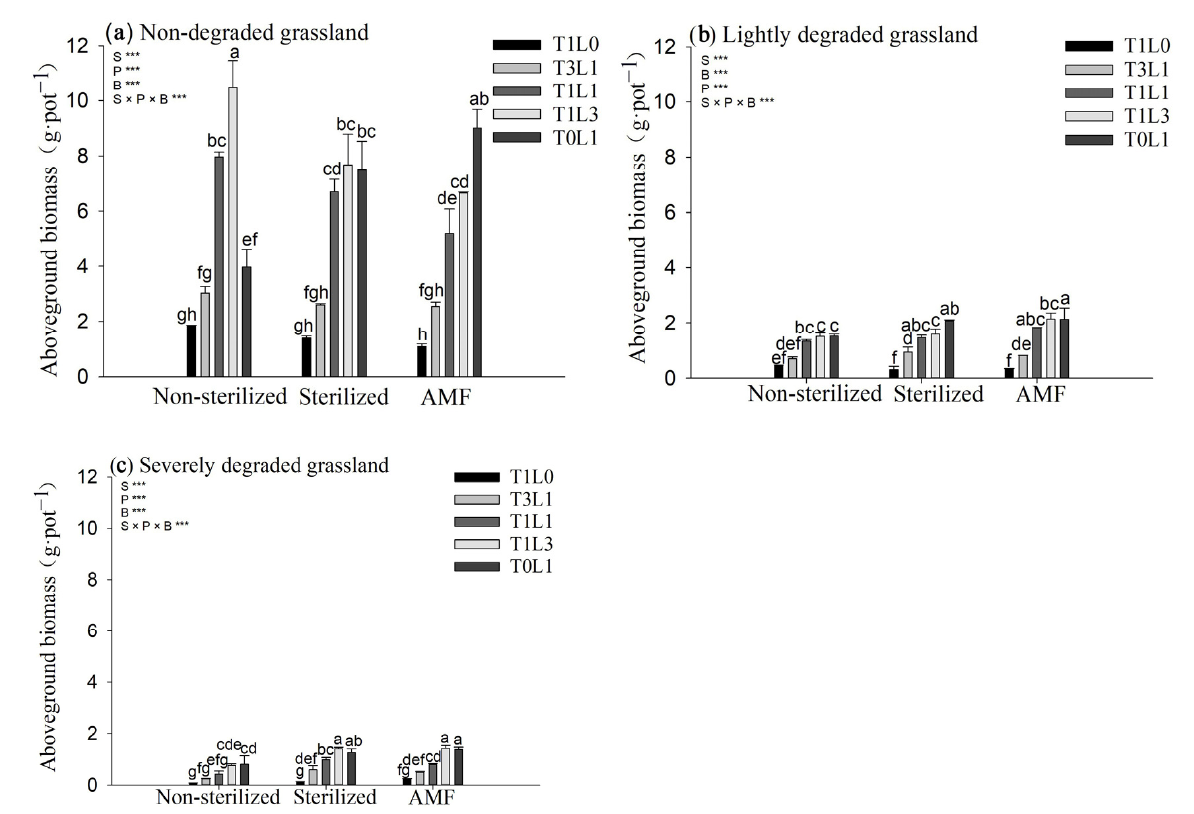
Figure 2. Effects of different treatments on plant community productivity. ( a ) Effects of soil type (S), planting ratio (P) , biological treatment (B) and their interactions (S × P × B) on aboveground biomass in non-degraded grassland soil ( b ) Effects of soil type (S), planting ratio (P) , biological treatment (B) and their interactions (S × P × B) on aboveground biomass in lightly degraded grassland soil. ( c ) Effects of soil type (S), planting ratio (P) , biological treatment (B) and their interactions (S × P × B) on aboveground biomass in severely degraded grassland soil. Different letters indicate the significant differences among treatments ( p < 0.05). *** p < 0.001 indicate the significance level of each treatment. Note: soil degradation degree (S); planting ratio (P); soil biological treatment (B). T1L0, T3L1, T1L1, T1L3, T0L1 mean planting ratio of T. repens and L. perenne : 1:0, 3:1, 1:1, 1:3, 0:1, respectively. Arbuscular mycorrhizal fungi inoculation improved the plant nutrient contents (Figures 3b and 4b,c). In LDG and SDG soils, AMF inoculation increased the plant shoot N and P contents. However, AMF inoculation did not improve the plant shoot N and P contents in NDG soil (Figure 3b). The plant shoot N content was the highest under T1L0 in NDG soil. AMF inoculation increased the plant shoot P content in plant communities with a high proportion of T. repens in LDG and SDG soils (Figure 4). The plant N/P ratio in NDG soil was significantly lower than that in LDG and SDG soils (Figure 5). Overall, for NDG soil, the average plant N:P ratio was 3.66 ± 0.34 (mean ± standard error); for LDG soil, it was 18.36 ± 1.25; and for SDG soil, it was 15.42 ±